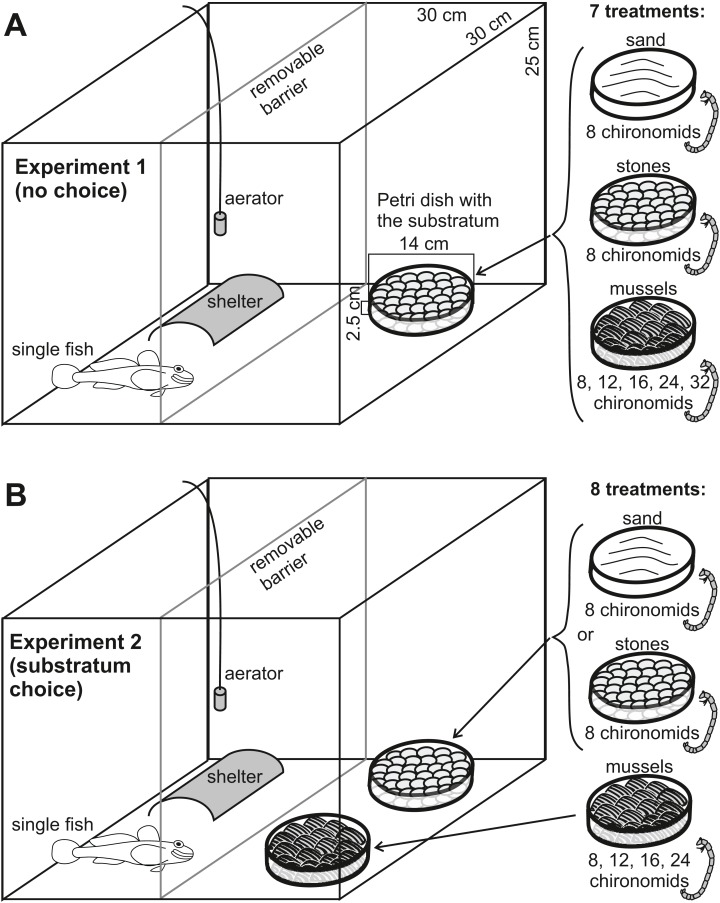
Experimental setup used in Experiment 1 (A) and in Experiment 2 (B).